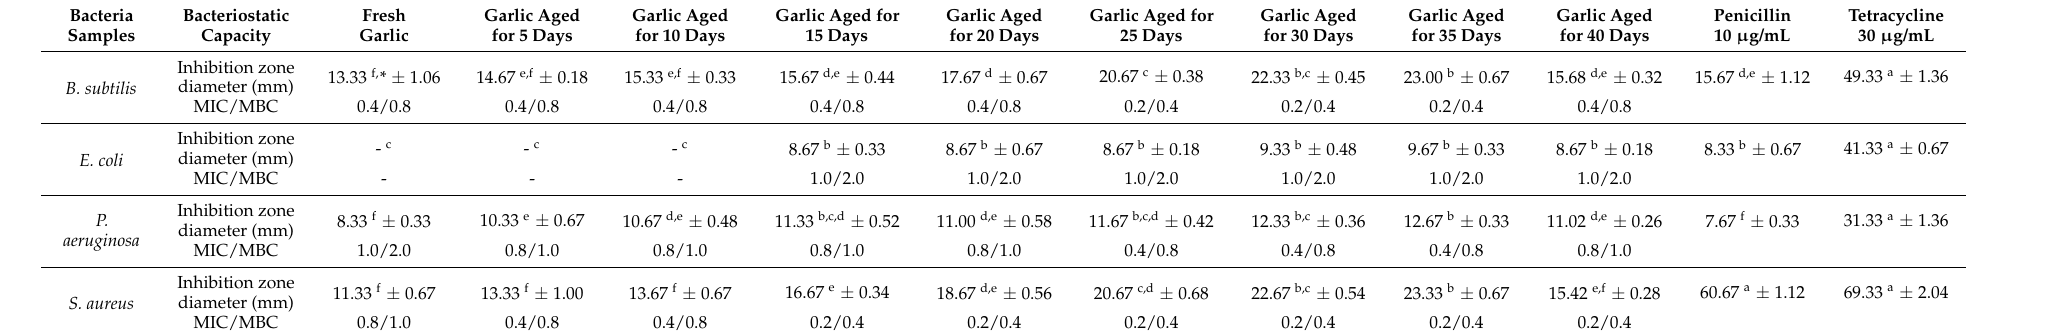
Table 3. Bacteriostatic capacity of extracts from fresh and aged